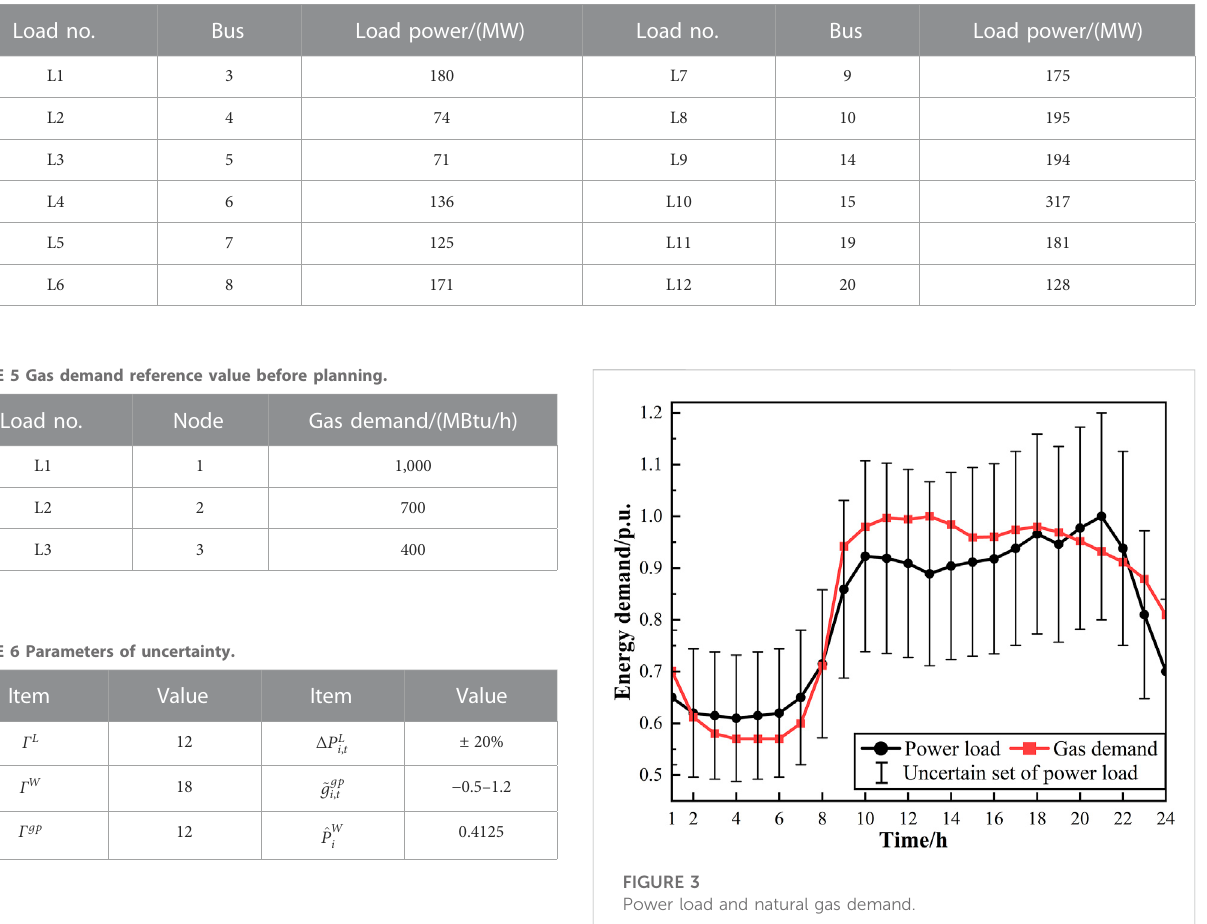
TABLE 4 Electrical load reference value before planning.